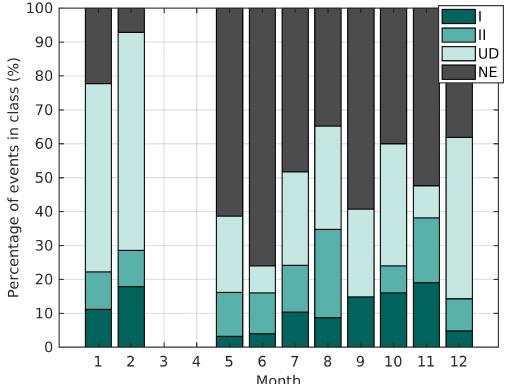
Figure 2. Bar plots show the fraction of each event class during each month. I stands for Class I, II for Class II, UD for undefined, and NE for non-event days.